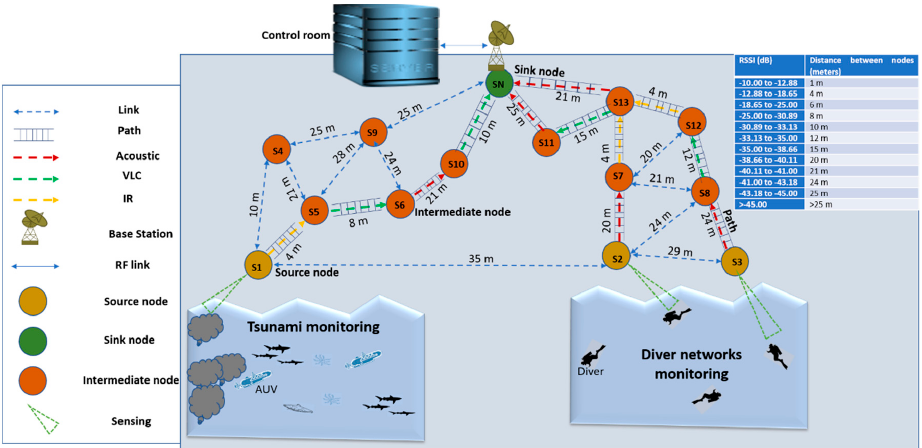
Figure 10 . Surveillance using the multi-media mechanism. Figure 10. Surveillance using the multi-media